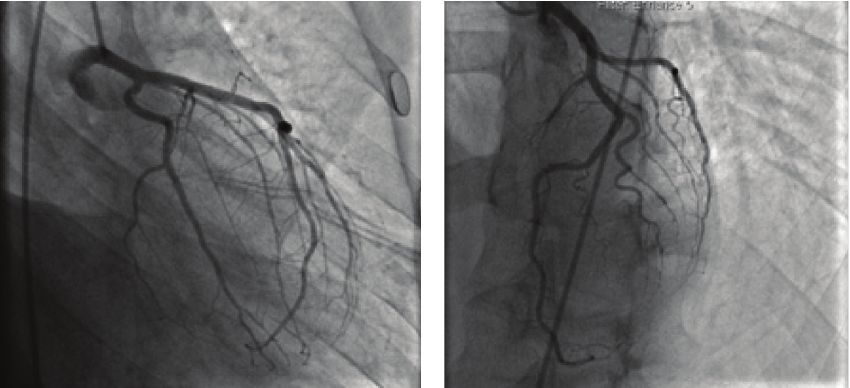
Figure 3: Normal LAD and LCX.